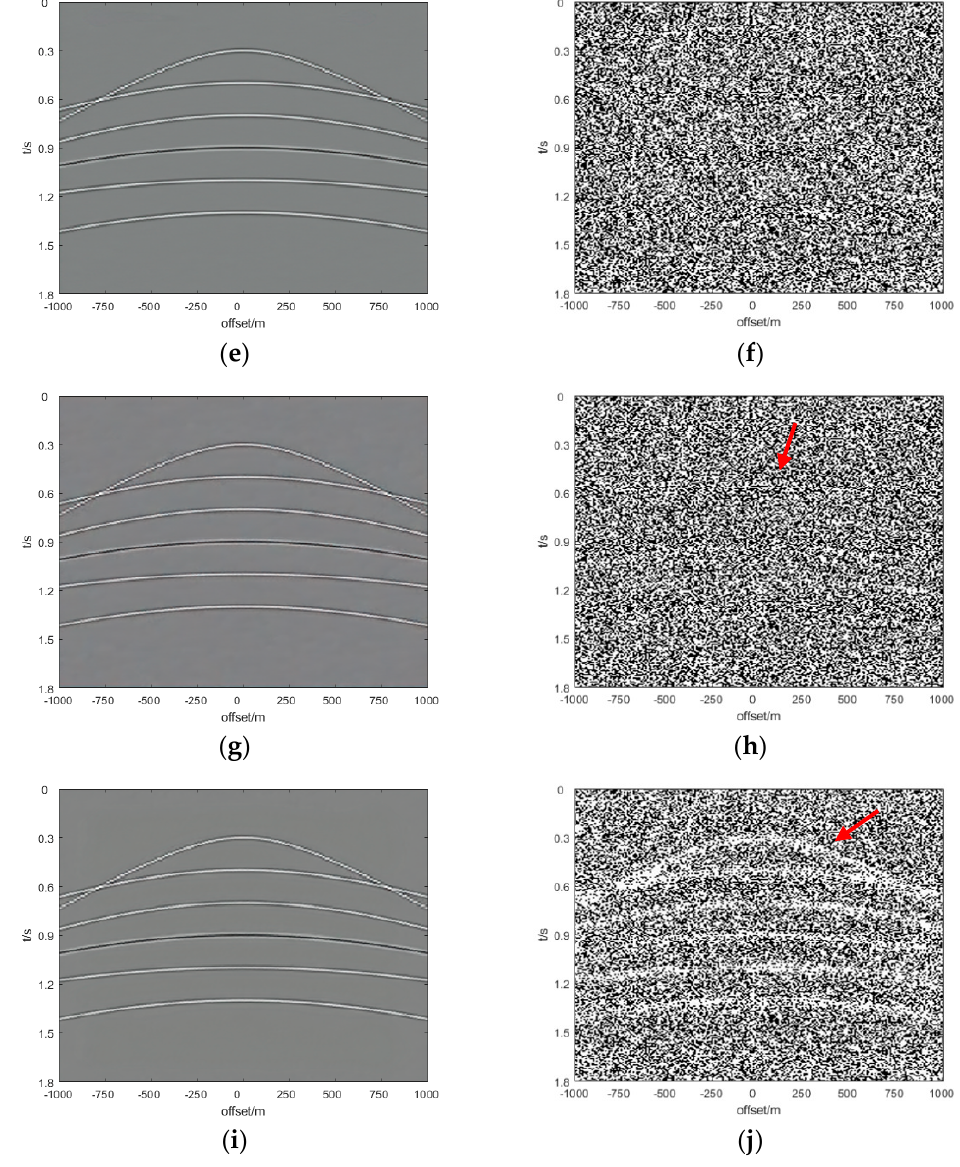
Figure 7. Denoising results of the hyperbolic events data. The red arrows on the right sides ( d , h , j ) of the figure plate mark the parts of the signal leakage. ( a ) Clean data; ( b ) Noisy data; ( c ) Denoised image through the pre-trained model; ( d ) Denoised data through the proposed method; ( e ) The difference profiles between noisy data ( b ) and pre-denoised data ( c ); ( f ) The difference profiles between noisy data ( b ) and denoised data ( d ); ( g ) Denoised data through the DnCNN; ( h ) The difference profiles between noisy data ( b ) and denoised data ( g ); ( i ) Denoised data through the U-net; ( j ) The difference profiles between noisy data ( b ) and denoised data ( i ).